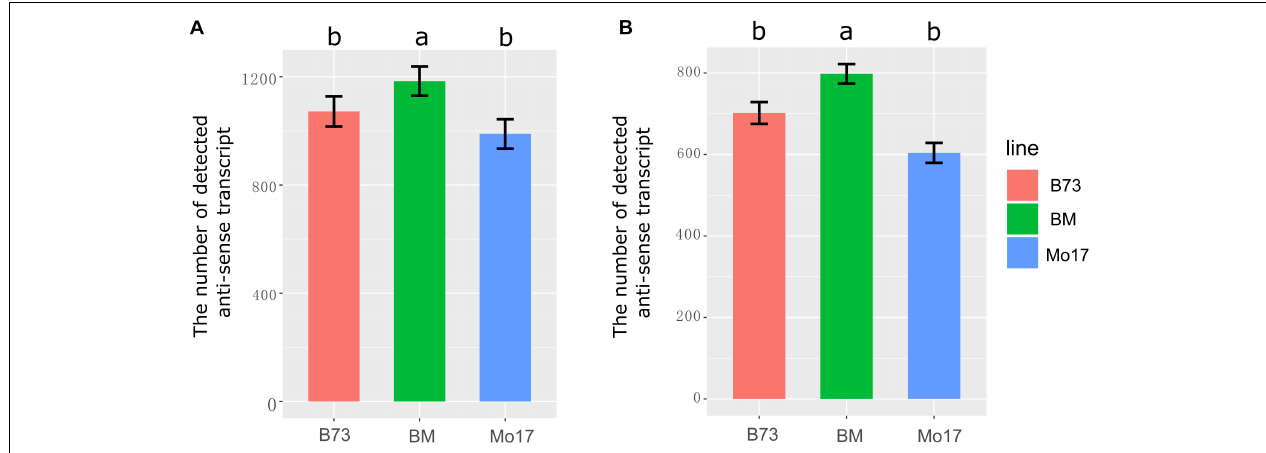
FIGURE 1 | The number of detected anti-sense RNA in immature ear and leaves in B73, Mo17, and their hybrid. (A) Immature ear. (B) Leaves. Different letters above the histogram indicate significant differences ( P < 0.05, Duncan multiple test). The ylab represents the number of detected anti-sense transcripts.